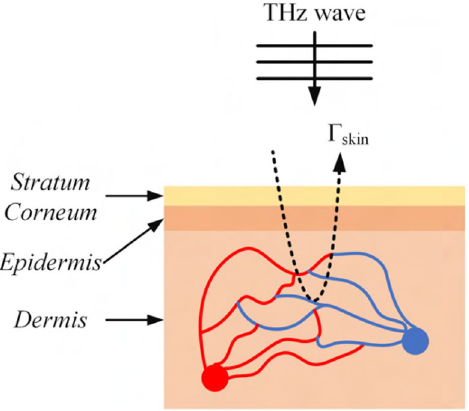
Figure 2. The upper skin structure during the cardiac cycle. In the systole phase, the blood volume is smaller leading to lower tissue conductivity. On the contrary, during the diastole, the arteries and capillaries expand, leading to more blood volume within the tissue, thus higher conductivity.